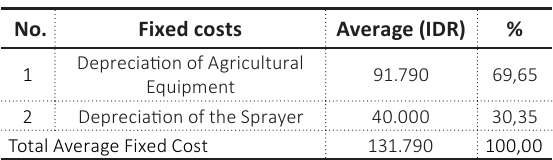
Table 2. Average fixed costs per ha planting season